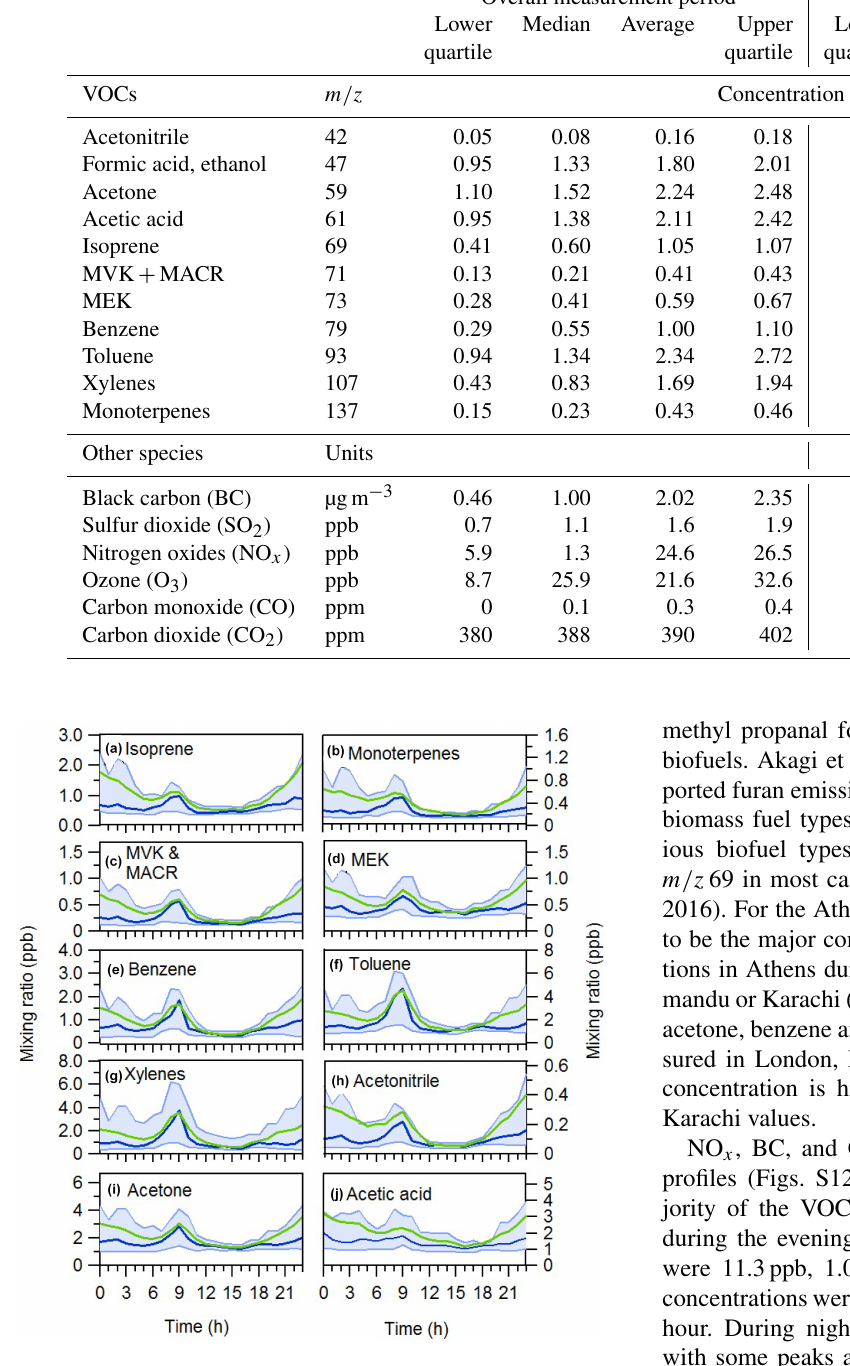
Figure 4. Average VOC diurnal profiles during the Athens winter campaign. Green lines present the average values. The median value is shown with blue. The blue area corresponds to the interquartile